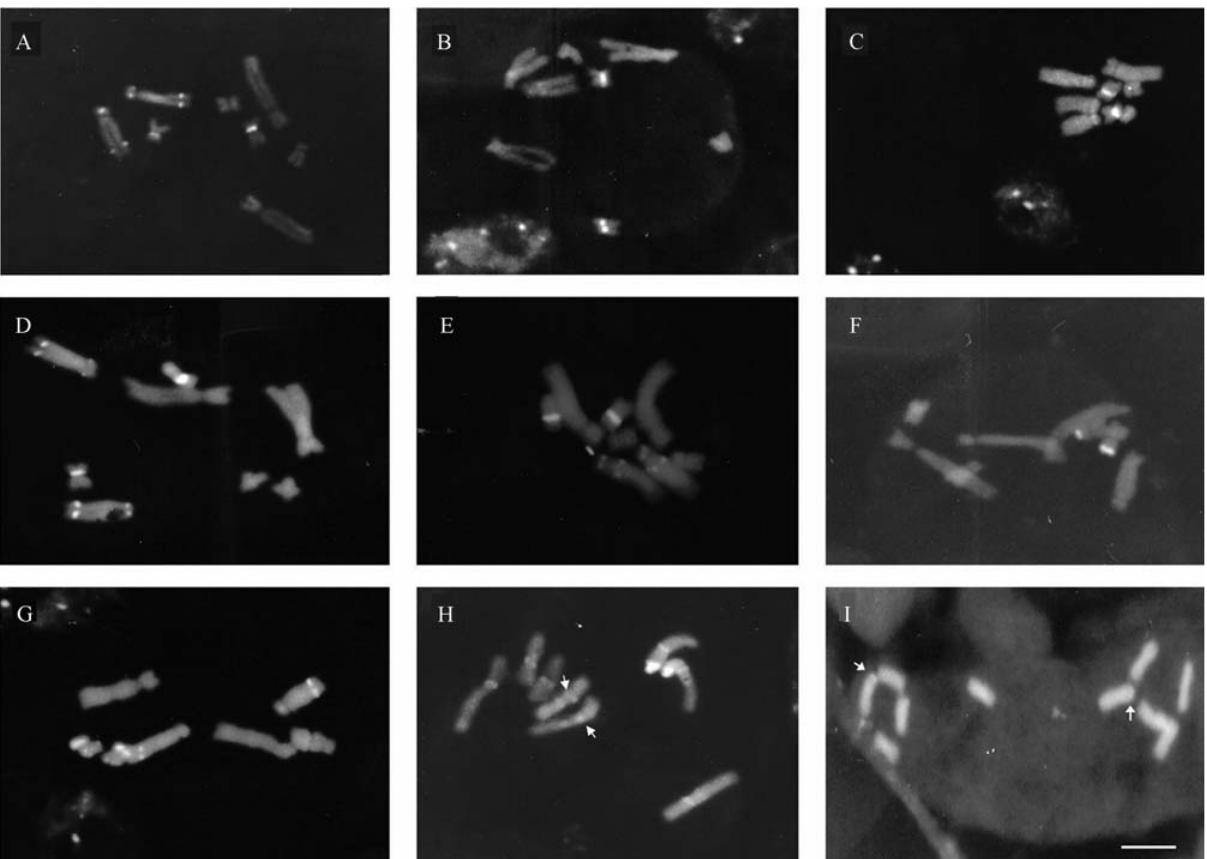
Figure 3 - Mitotic metaphases stained with chromomycin A 3 showing the distribution of GC-rich heterochromatin in Hypochaeris species: (A) H. brasiliensis , (B) H. grisebashii , (C) H. megapotamica , (D) H. microcephala , (E) H. pampasica , (F) H. rosengurttii , (G) H. variegata , (H) H. glabra , and (I) Hypochaeris sp (arrows = weak CMA 3 bands) . Bar = 6 µ